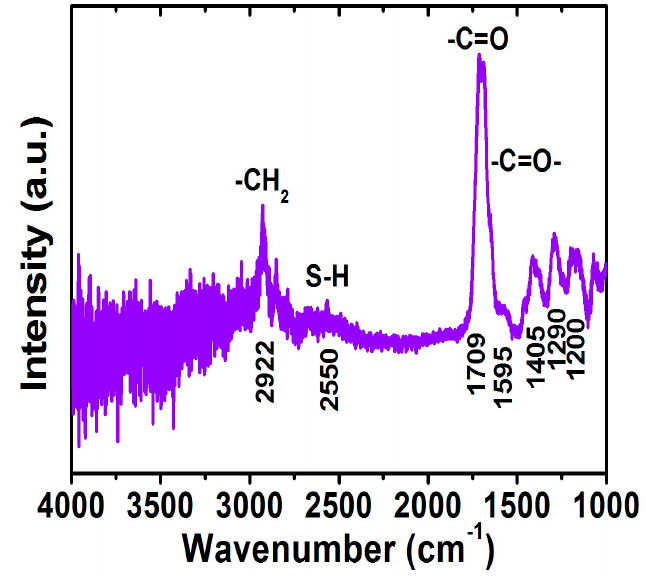
Figure 6. FTIR spectrum for the FePt NPs after ligand exchange with thiol.